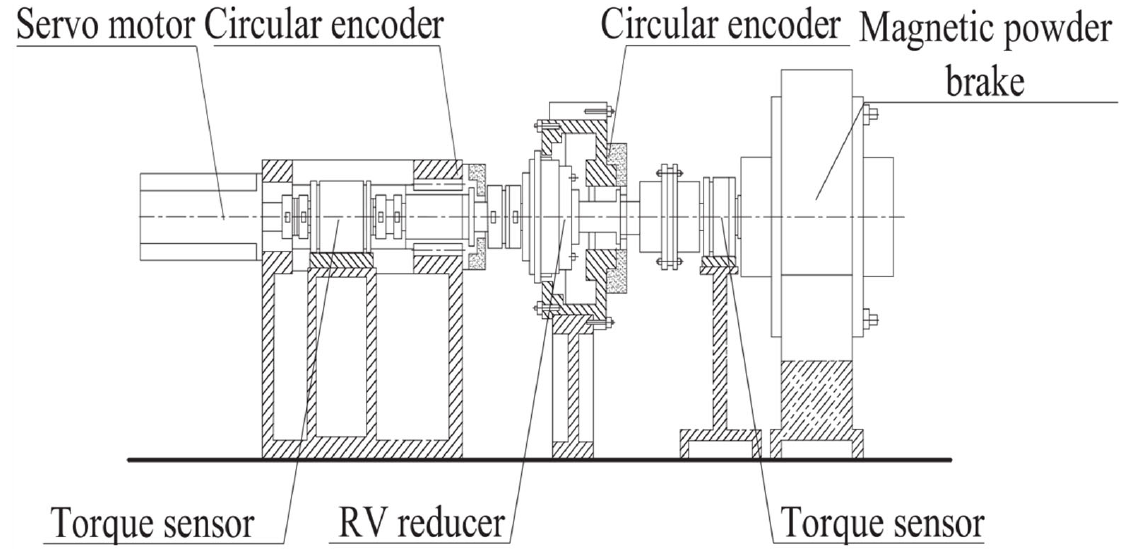
Figure 2. Schematic diagram of RV reducer rotation error test bench. When testing each reducer, the test bench is configured with the same speed and load, the rotation error data of each RV reducer in the stable operation is recorded, and the average value is considered the rotation error value. Adjust the servo motor speed to 1200 rpm, set the load bit to 200 N · m, record the rotation error after the reducer has stabilized, and select at random the test curve chart for three reducers, as depicted in Figure 3. The sample point of the factor-rotation error is the sum of the value of the rotation error received from the test and the deviation of each influencing